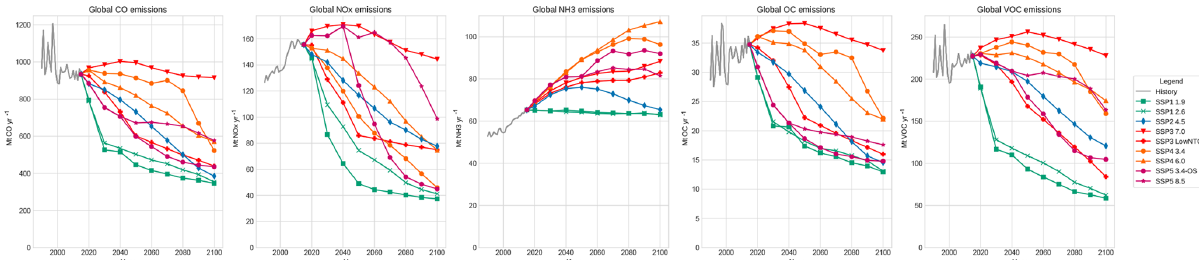
Figure E3. Emissions trajectories for all aerosols and all scenarios analyzed in this study.